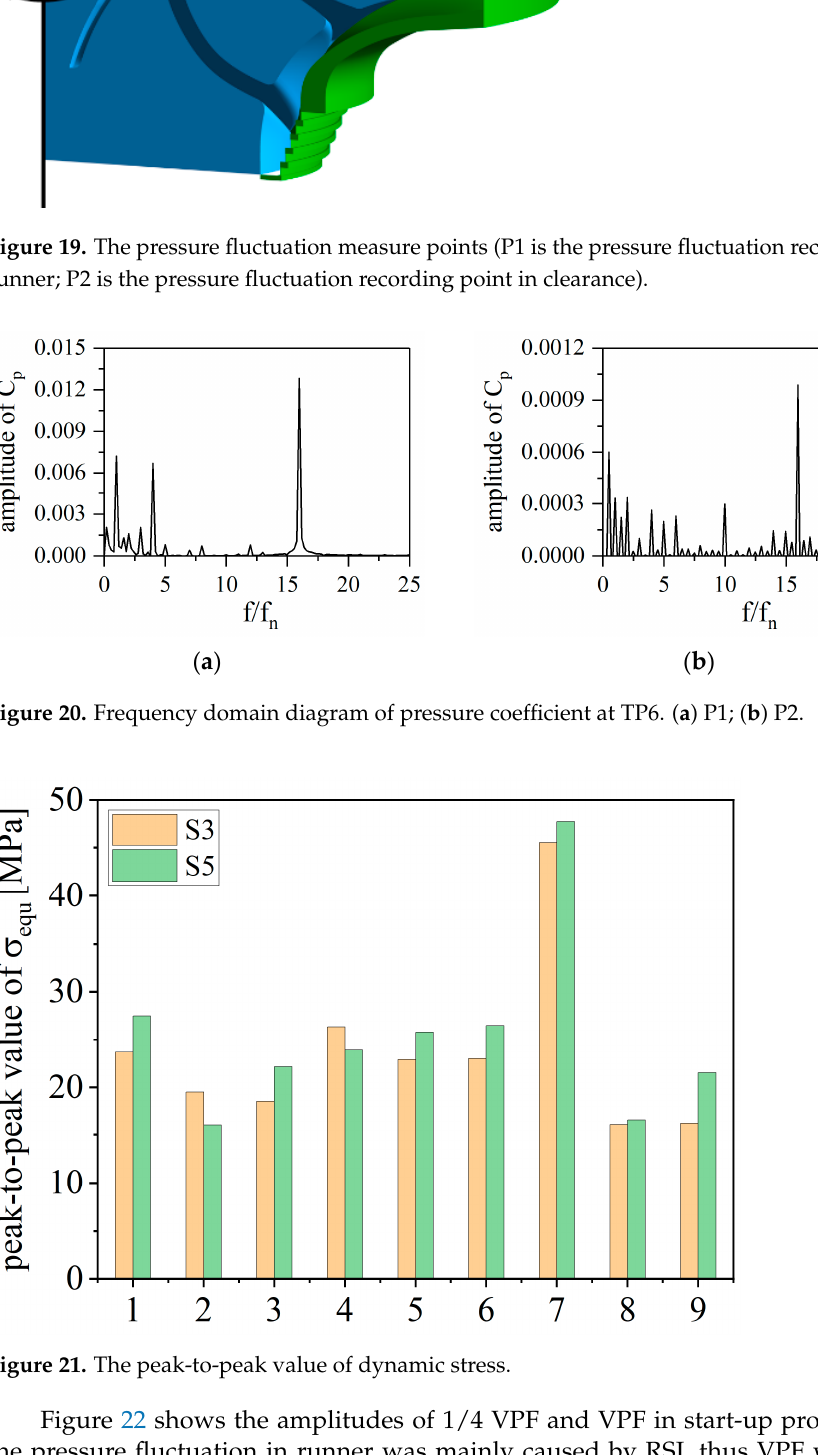
( b ) Figure 22. The dynamic stress amplitude of 1/4 VPF and VPF. ( a ) S3; ( b ) S5. The modal analysis was performed to tell whether the sudden rise of 1/4 VPF was caused by resonance. The natural frequency of first mode is 95.95 Hz and the mode shape is shown in Figure 23. There is a nodal diameter in this mode shape, so it is usually marked as 1ND [28]. This is a common mode shape for most runners and other structure similar with the disc [29,30]. The rotating rate at TP7 is 489.24 rpm, and the value of 1/4 VPF is 32.62 Hz, far from 95.95 Hz. Therefore, the steeply increase of dynamic stress at TP7 is not the contribution of resonance.